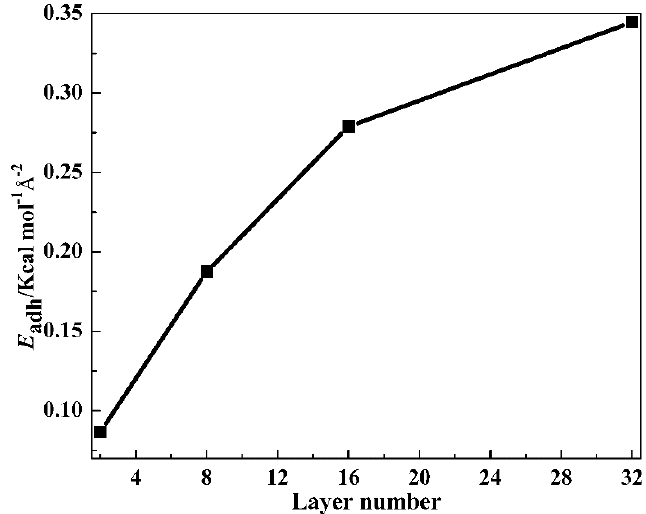
Figure 7. The overall adhesion energy of the TP system.